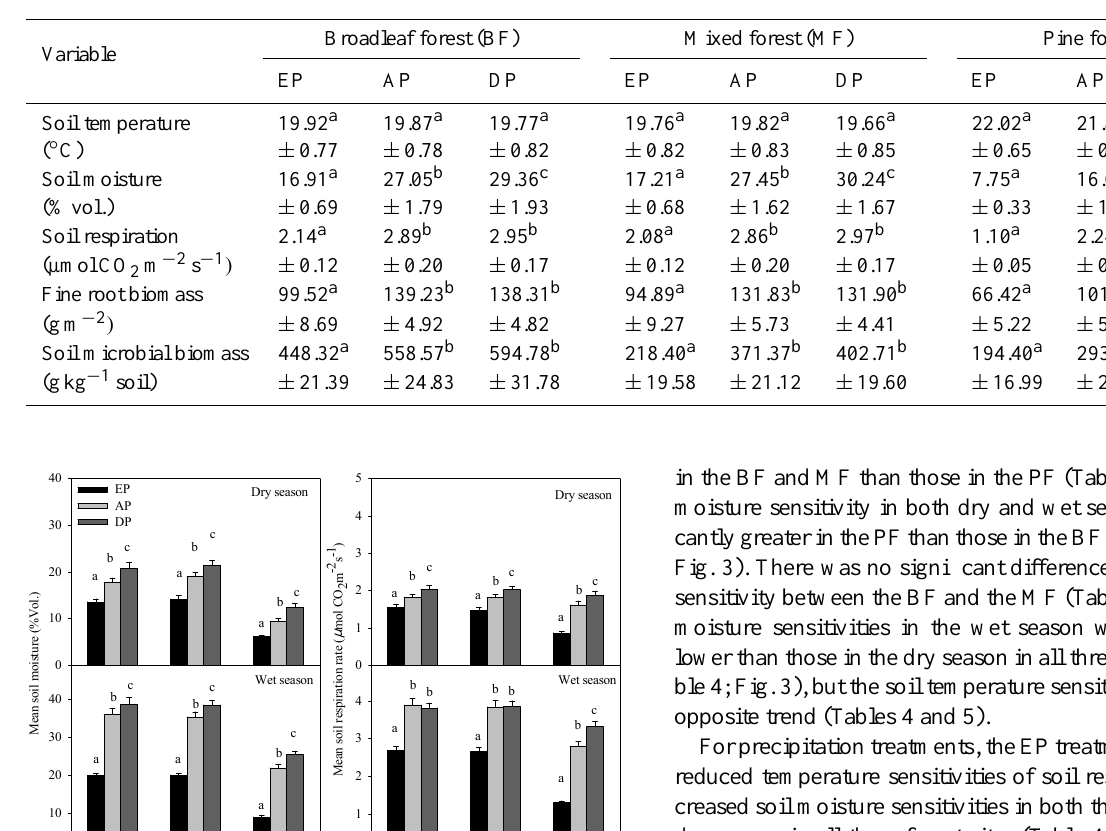
Table 3. Mean annual values of soil temperature at 5cm depth, soil moisture of the top 5cm soil layer, soil respiration rate, fine root biomass and soil microbial biomass under ambient precipitation (AP), precipitation exclusion (EP) and double precipitation (DP) treatments from the broadleaf forest (BF), the mixed forest (MF) and the pine forest (PF) (mean ± standard error). Mean values in each forest site within a row with a different superscripted letter have significant treatment differences at α = 0 . 05 level.